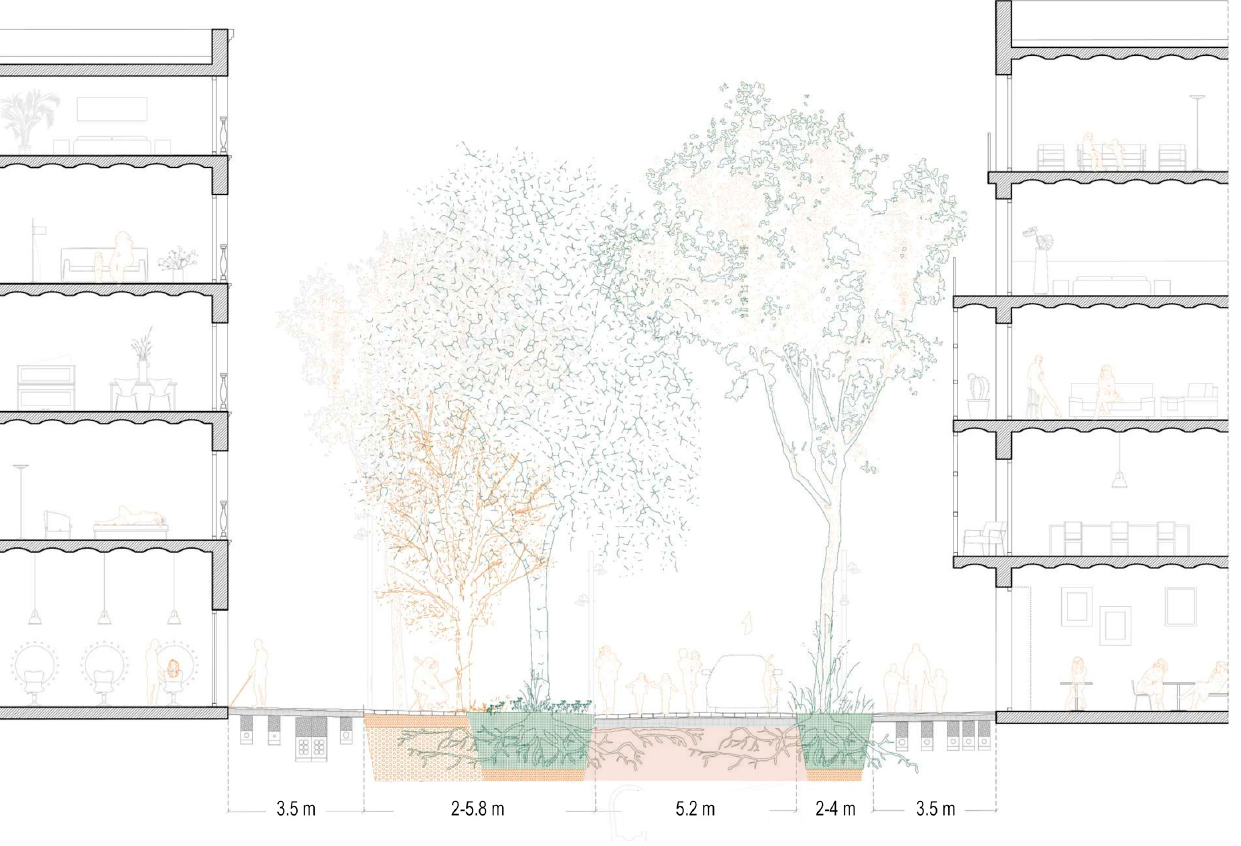
Figure 13. Typical distribution of spaces in a green axis in a standard 20-m-wide street, including pedestrian safe zones by the buildings (services below), planting areas and shared spaces (with structural soil underneath). Source: Adapted from Ajuntament de Barcelona [56].